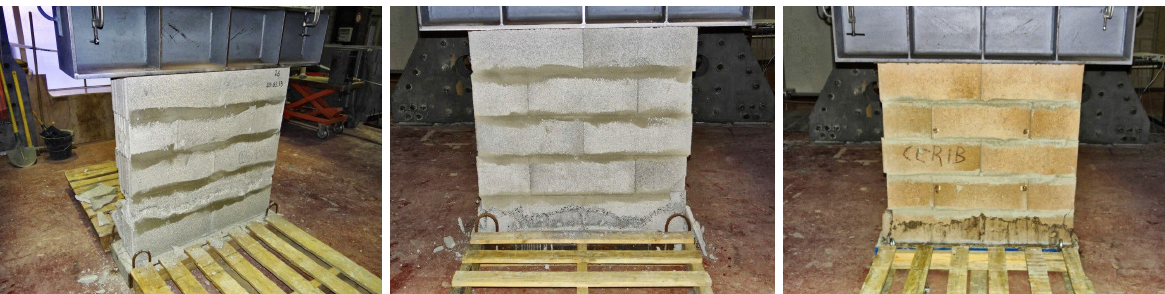
Fig. 7. Typical failure of lightweight aggregates masonry